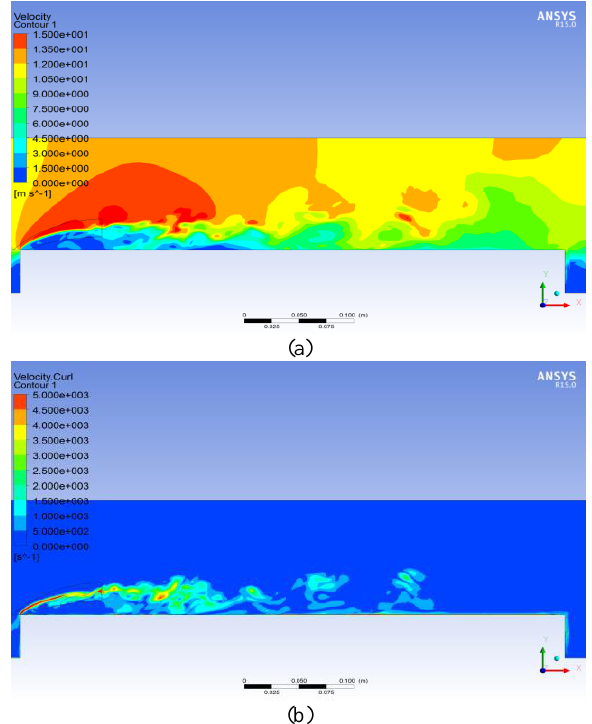
Fig.11. Distribution of the velocity magnitude (a) and vorticity intensity (b) in the central cross-section of the obstacle (instantaneous